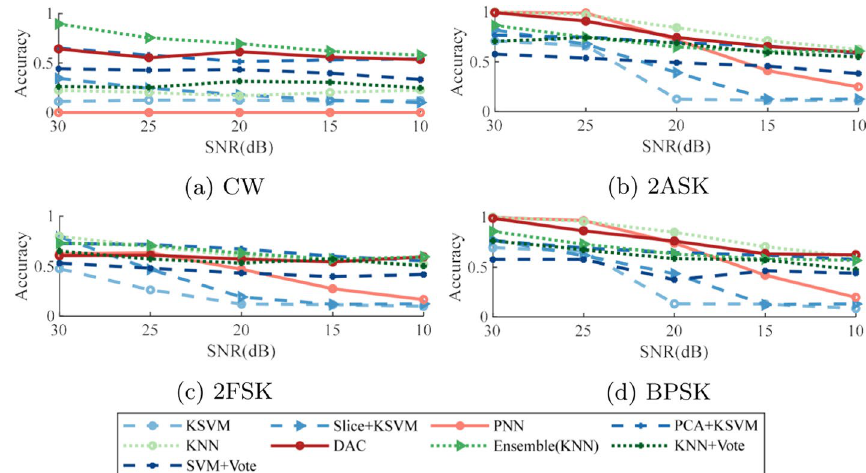
Fig. 9 Accuracy using different classifiers